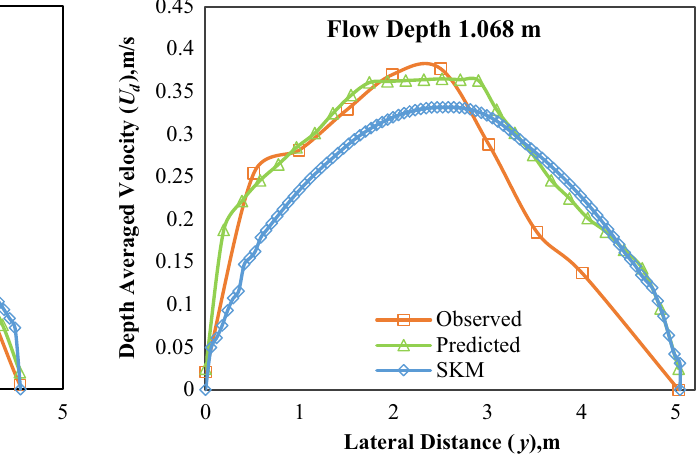
Fig. 20 Depth-averaged velocity of river